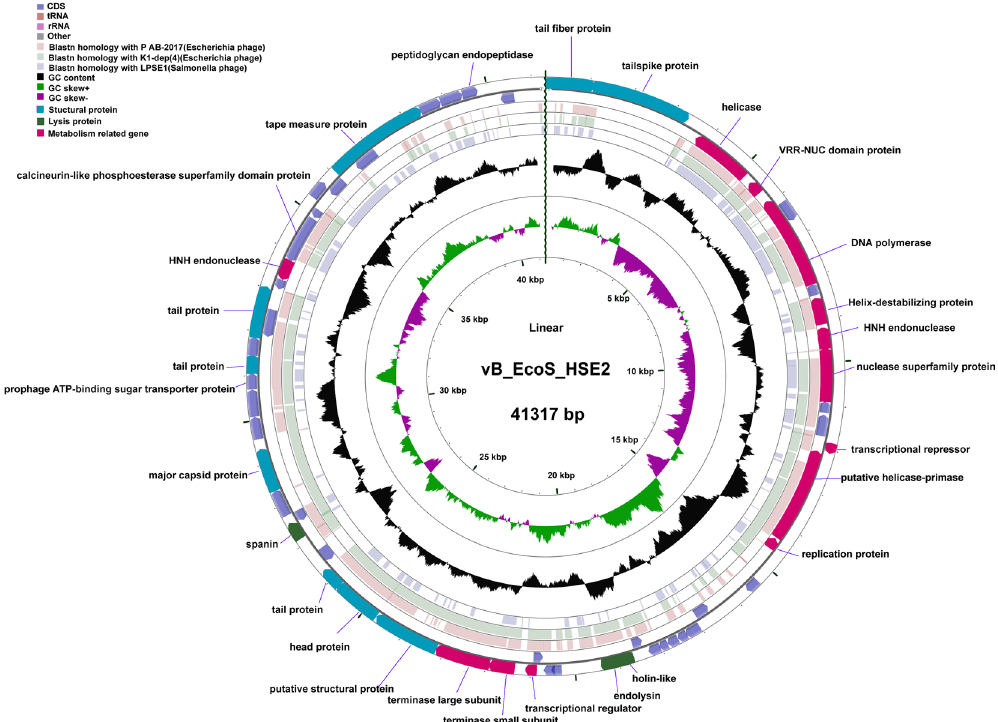
Figure 3. Genome structure of phage vB_EcoS_HSE2 and comparative genomic analysis with phage P AB- 2017, K1-dep(4) and LPSE1. The outermost ring presented the CDSs of the linear vB_EcoS_HSE2 genome (blue) and the adjacent three rings showed BLASTN homology between vB_EcoS_HSE2 and P AB-2017 (pale pink), K1-dep(4) (pale green), and LPSE1(pale blue). The middle ring indicated the GC content (black), and the innermost ring represented the GC skew of vB_EcoS_HSE2 genome. The predicted functions of the CDSs were